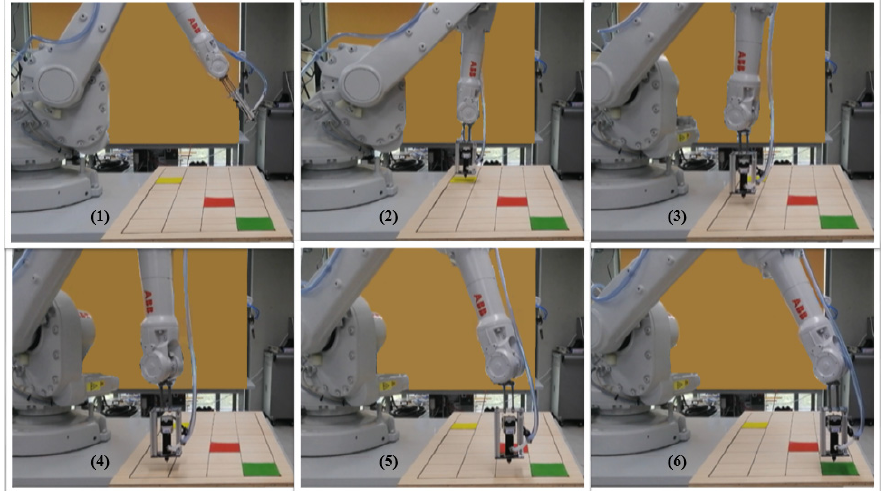
Figure 8. Real-world test. ( 1 ) Initial position of end-effector before starting the process. ( 2 ) The robot starts moving from the start point in yellow. ( 3 – 5 ) The robot track the found path while avoiding the obstacle. ( 6 ) The robot reaches the target in green.